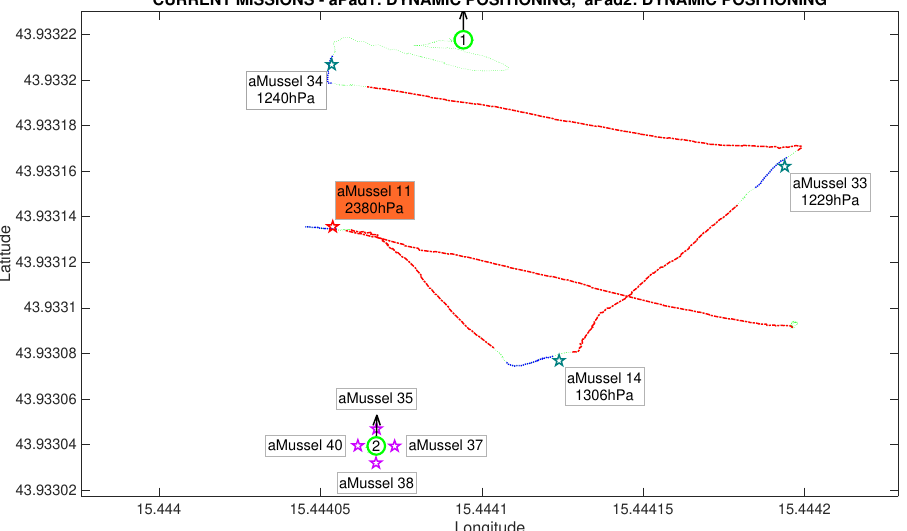
Figure 14. Outlier detection completed in the Anoxia scenario experiment results from the deployment phase, reconstructed and replayed from recorded vehicle data—Biograd na Moru